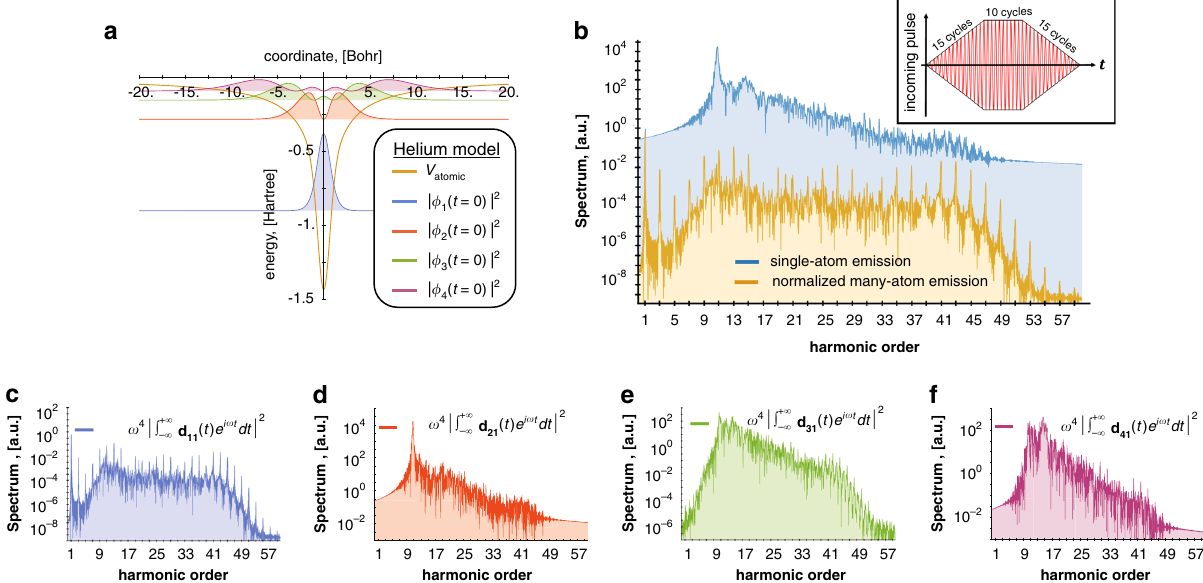
Fig. 2 Single-atom and many-atom high harmonic generation (HHG). a 1D model of a helium atom and its electronic states (| ϕ 1 〉 , | ϕ 2 〉 , | ϕ 3 〉 , etc.) without an external driving fi eld. This model of a helium atom is used for all the simulations in our work. b Emission spectrum calculated using Eq. (5) (yellow curve), which presents the HHG emission by many ( N ≫ 10 4 ) atoms normalized by N 2 vs. summing the fi rst four elements in Eq. (4) (blue curve), which presents the emission by a single atom. c – f Contributions to the single-atom HHG spectrum, corresponding to different transition matrix elements, all having the same normalization. The wavelength of the driving fi eld is λ 0 = 800 nm; the intensity of the driving fi eld is I = 2 10 14 W cm − 2 . The form of the pulse is shown in b — trapezoidal pulse with 15 cycles rising on each side of trapeze and 10 cycles of the plateau of the trapeze. In many-atom emission, only c gives a coherent contribution (~ N 2 ) to the emission, while d – f give an incoherent contribution (~ N